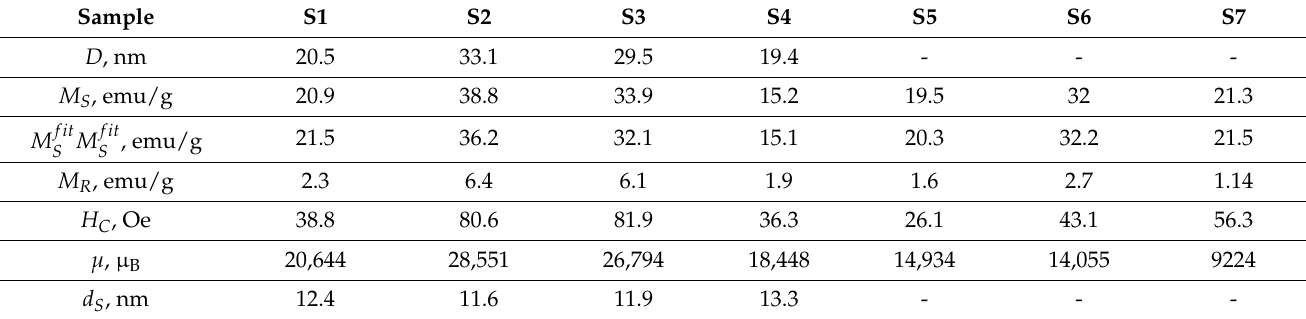
Table 1. Average crystallite size and magnetic parameters of the as-synthesized sample and samples after high-temperature magnetic measurements. Here, D is the average crystallite size, M S is the saturation magnetization, M fit is the value of saturation magnetization obtained from the best fitting S of the curves using the Langevin function, M R is the remanent magnetization, H C is coercivity; µ is the mean magnetic moment, and d S is the average magnetic domain